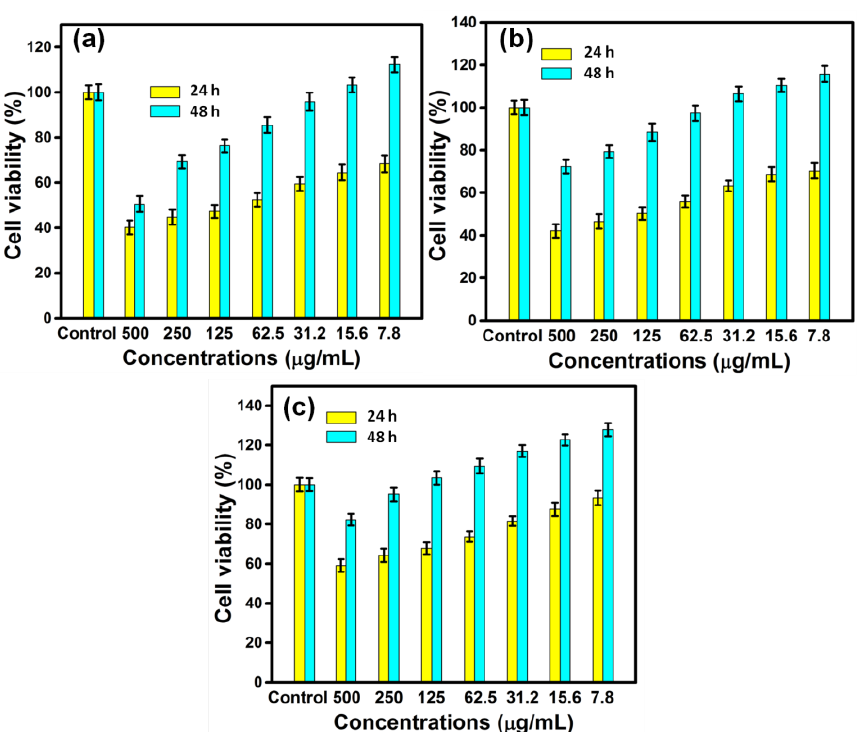
Figure 6. Biocompatibility results of ( a ) RE-Ac-Ag, ( b ) RE-Et-Ag, and ( c ) RE-Aq-Ag (values with mean + SD, n = 3).